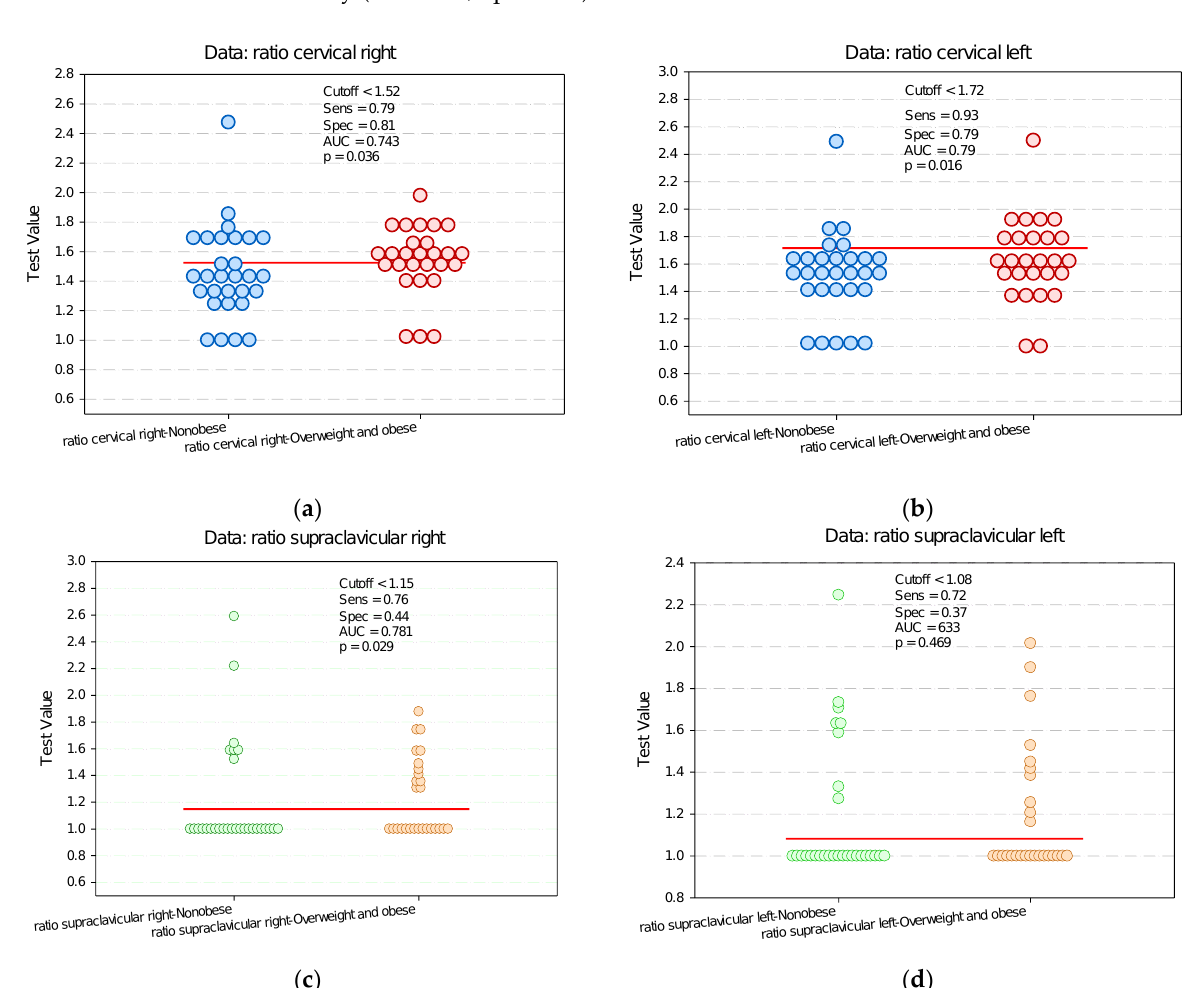
Figure 7. Paired histograms for estimating the cut-off value of (total counts/pixels) BAT /(total counts/pixels) non-BAT ratio in cervical ( a , b ) and supraclavicular localizations ( c , d ).